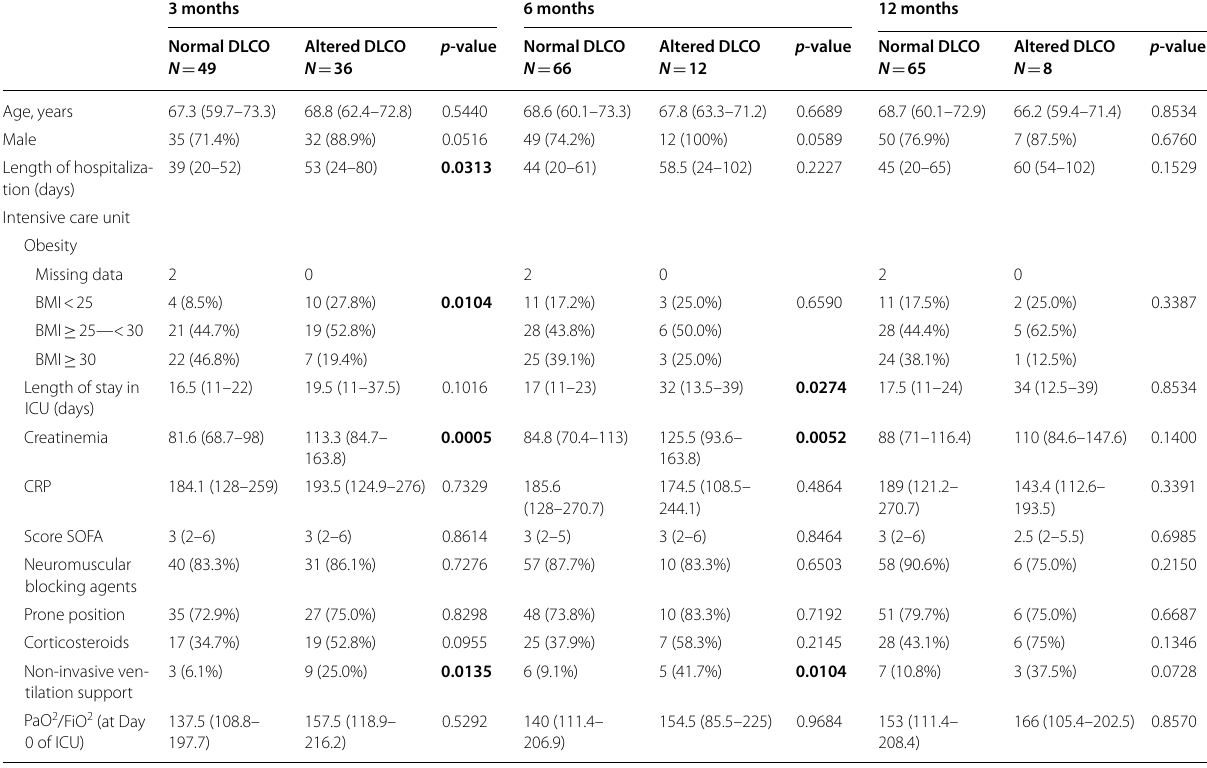
Values are presented as medians (interquartile ranges) or number of patients (percentages) DLCO diffusing capacity of the lung for carbon monoxide, BMI body mass index, CRP C-reactive protein, SOFA Sequential Organ Failure Assessment, PaO 2 /FiO 2 partial pressure of oxygen/fraction of inspired oxygen, ICU intensive care unit